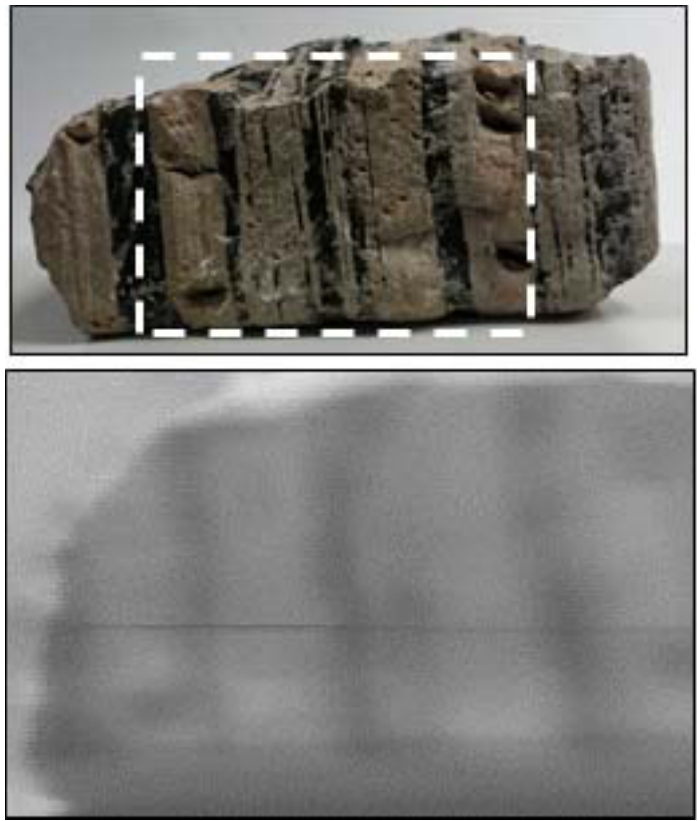
Figure 7. Example image captured using the low-cost hyperspectral imager displaying the presence of flow banding. Hyperspectral image taken from 613 nm of a 256 × 256 pixel scan.